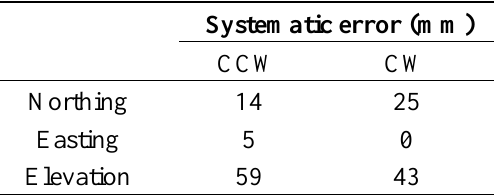
Table 2. Systematic errors for the ROAMER data. Driving directions: counter-clockwise CCW, and clockwise,